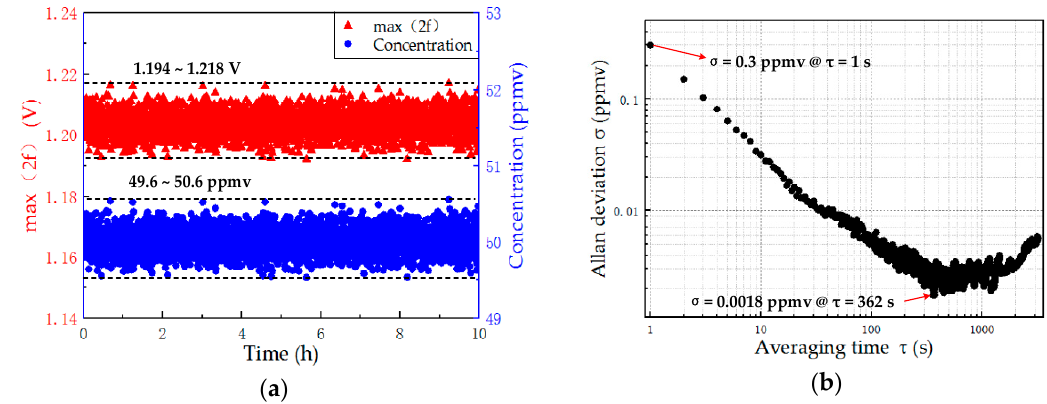
Figure 9. ( a ) Results of the stability test of 50 ppmv C 2 H 2 . ( b ) Analysis of Allan deviation for long-term characteristics of the detection system.